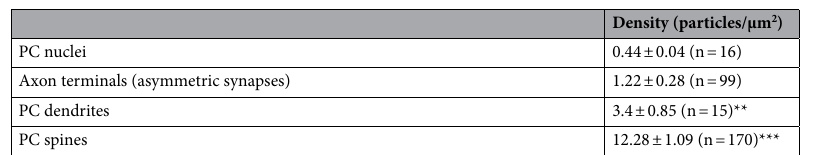
Table 1. Cortactin labeling gold particle density over various neuropil compartments in the superficial molecular layer) of the cerebellar cortex. Random profiles were classified into the above categories, regardless of immungold content. To assess non-specific/background labeling, Purkinje cell nuclei (from the Purkinje cell layer) were also examined. Spines and shafts of PCs showed robustly significant differences from nuclear background (P < 0.001, and P < 0.01, respectively), while axon terminals had notably fewer particles, not significantly different from the background (P = 0.8). (± values: one-way ANOVA with post-hoc Tukey tests; n: profile sample